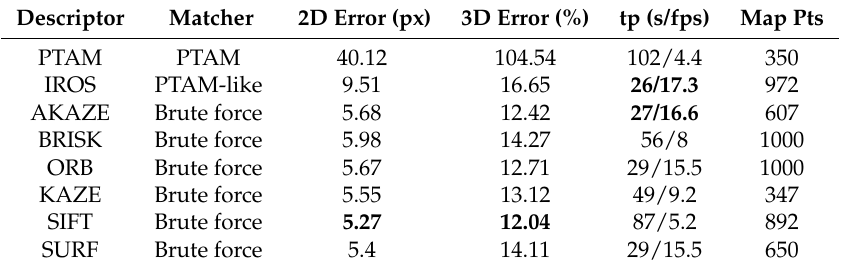
Figure 6. Rendered flag sequence screenshots and reconstructions for IROS and SIFT matching. ( a ) IROS screenshots, ( b ) SIFT screenshots, ( c ) IROS reconstruction results, ( d ) SIFT reconstruction result. Table 4. Rendered flag sequence descriptor results comparison. As references, the original PTAM algorithm, the PTAM-based tracking and the descriptor-based results are